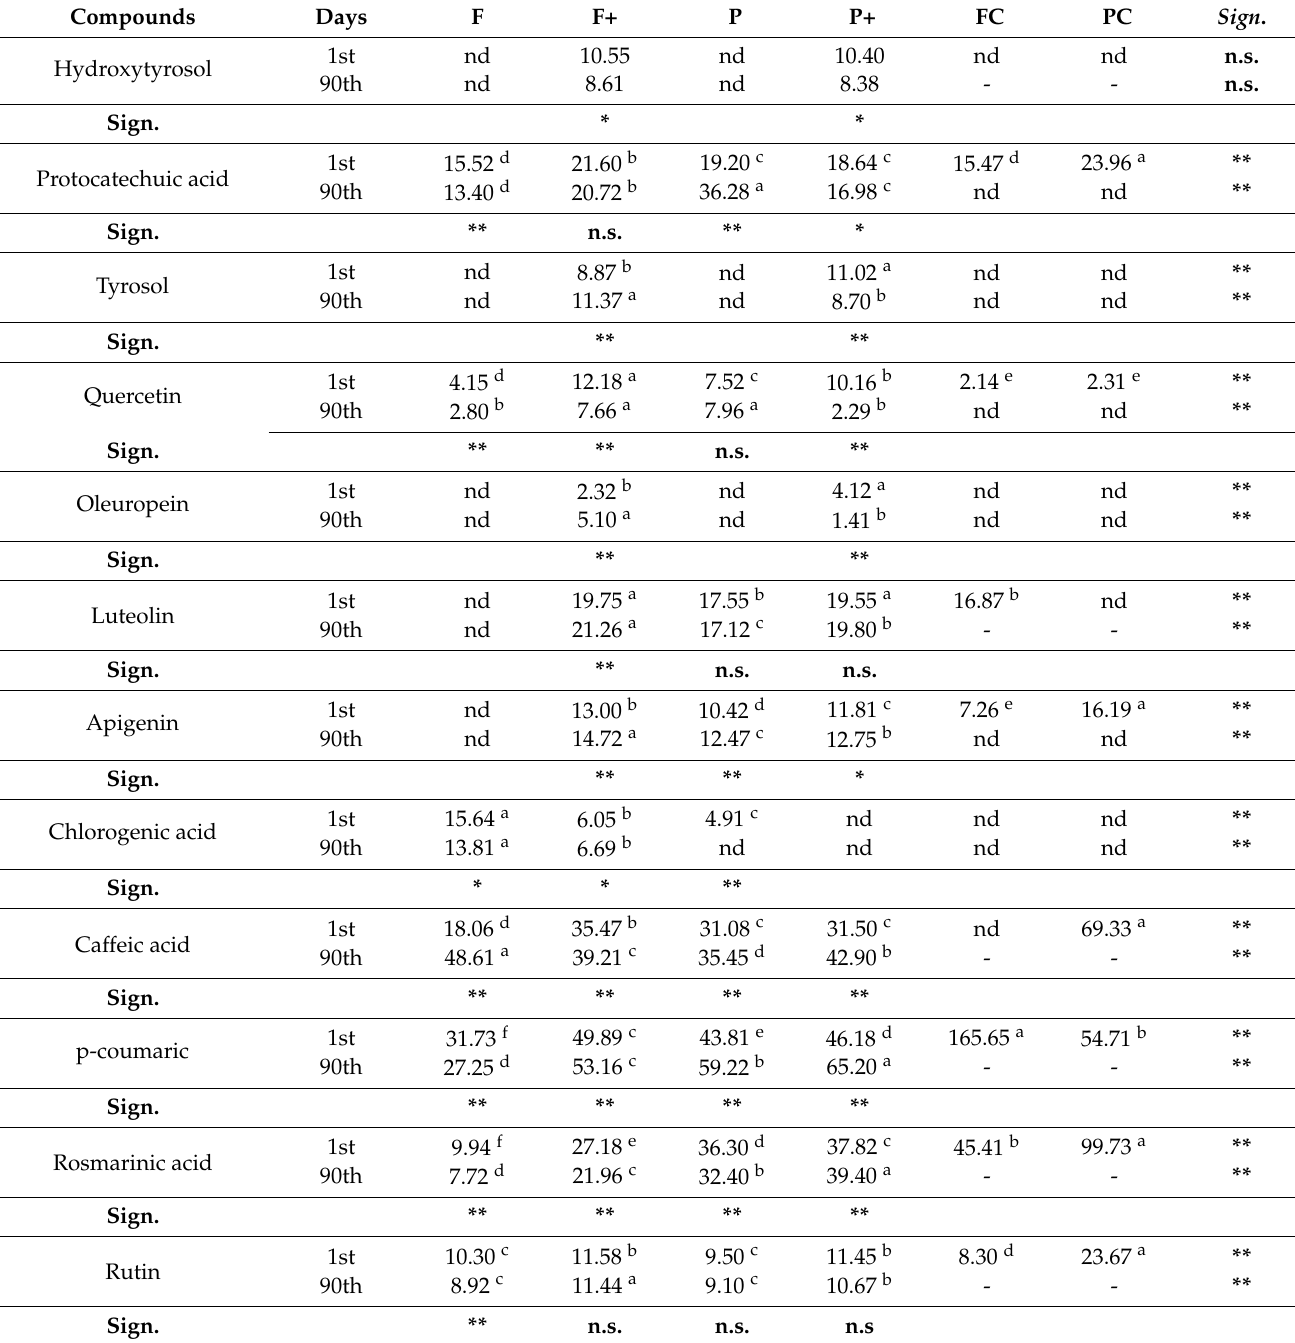
Table 6. Individual phenolic content of pesto samples during storage period (mg kg − 1